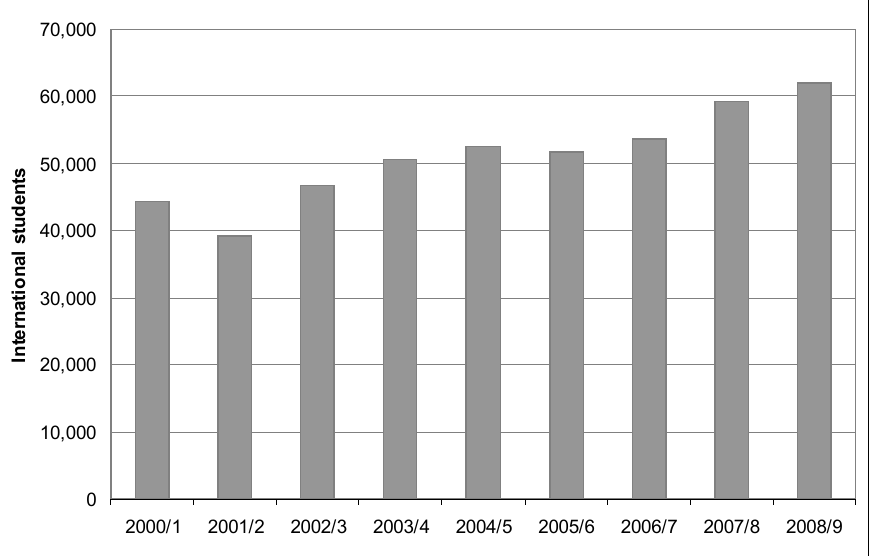
FIGURE 1: Total number of international students at public HEIs in SA, 2000-2008